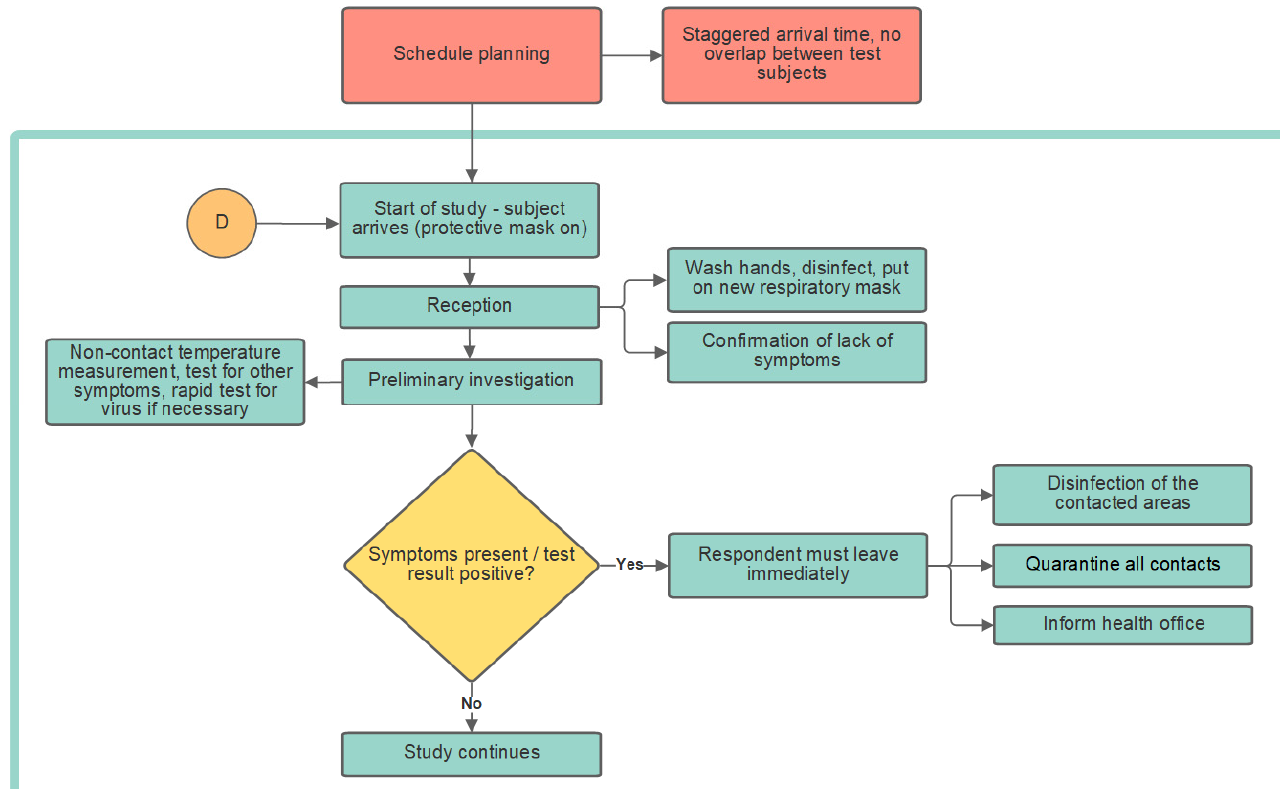
Figure 9. Planning of the schedule and study procedure.